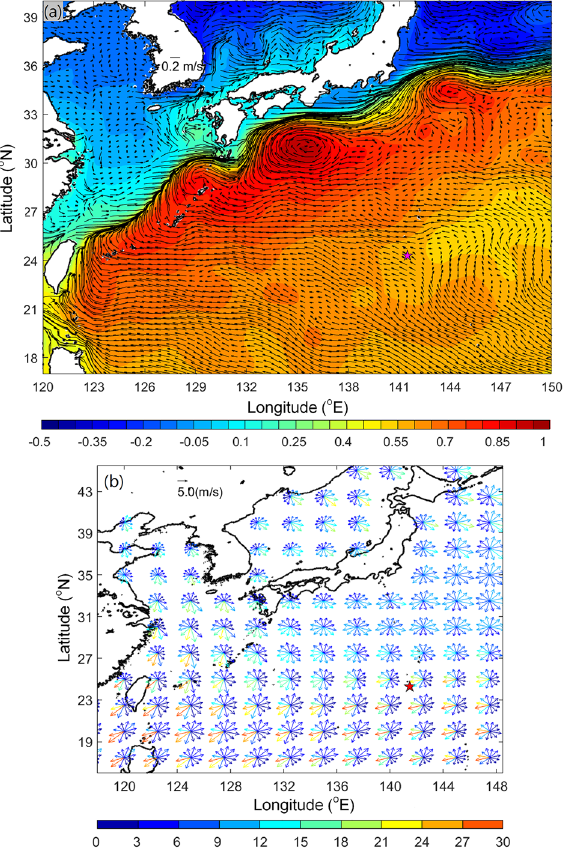
Figure 3. Ensemble-averaged data for the August to December period from 1993 to 2020 ( a ) Ocean surface currents (vectors, m/s) and sea surface height anomaly (SSHA, color, meter) ( b ) Wind roses in the western North Pacific, showing winds (vectors, m/s) and percentage occurrence (color) in indicated directions. Star indicates the eruption site at Fukutoku-Oka-no-Ba. Figure is created using MATLAB R2011b (http:// www. mathw orks.